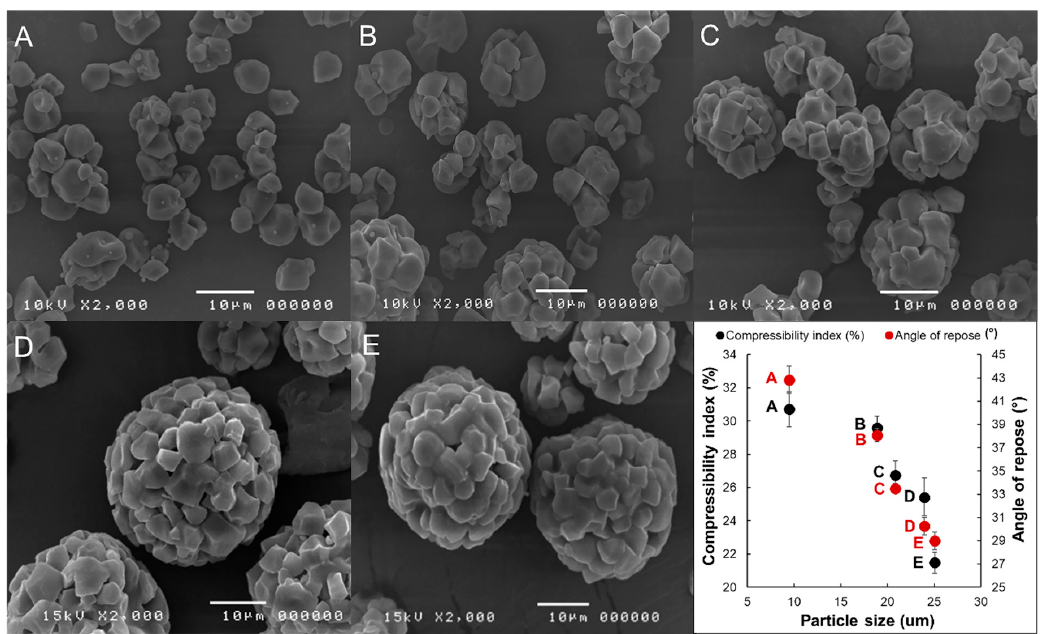
Figure 1. SEM images, particle mean diameter, and flowability parameters of preliminary co - processed rice starches ( PCSs ) prepared using different spray drying condiditons (nozzle tip size, solid content level). ( A ) 0.7 mm, 20%; ( B ) 1.4 mm, 20%; ( C ) 2.0 mm, 20%; ( D ) 2.0 mm, 30%; and ( E ) 2.0 mm, 40%.